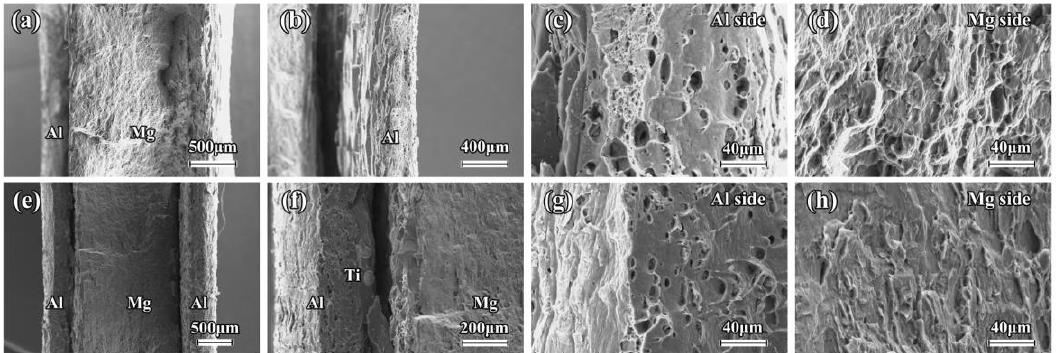
Figure 12. Tensile fracture features of composite sheets annealed at 400 °C for 10 h: ( a – d ) Mg/Al sheet, and ( e – h ) Mg/Al - Ti sheet.